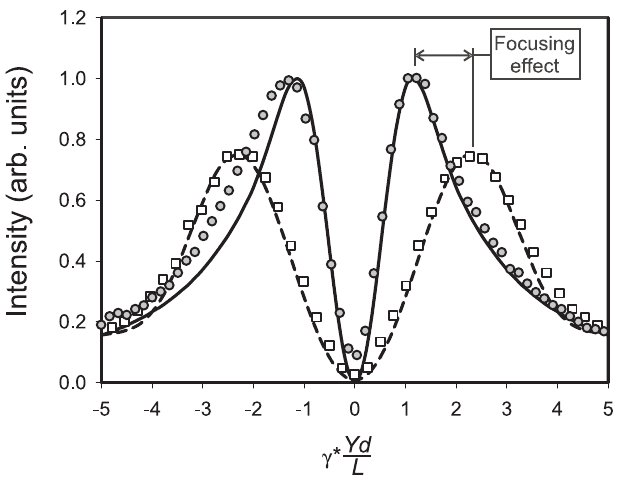
FIG. 5. The OTR vertical polarization component spatial dis- tributions along the Yd direction ( Xd ¼ 0 ). Gray dots—spherical target experiment; white squares—flat target experiment; solid line—spherical target theory; dashed line—flat target